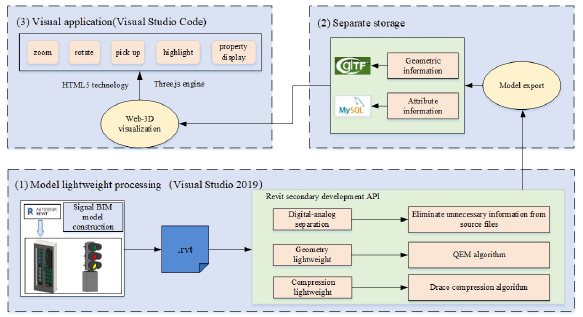
Fig. 1. The research